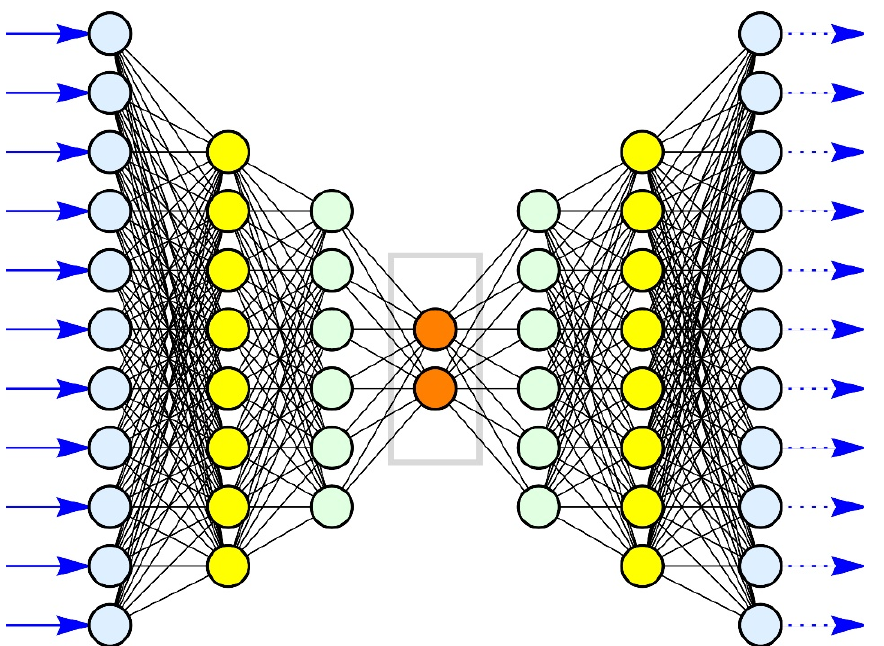
Figure 1. A symbolic rendition of an autoencoder used for dimension reduction. The 11 inputs (in the drawing) are represented by blue arrows from left to right. The inputs are conventionally labelled neurons (hence the name “neural network”). Each input neuron (light blue) has as many outputs as there are neurons in the next layer. Each ‘yellow’ neuron thus has 11 inputs/edges (represented as thin black lines). Each neuron in the yellow layer has as many outputs as there are neurons in the next layer: six outputs for each ‘yellow’ neuron and therefore eight inputs for each ‘green’ neuron of the next layer. It continues: each ‘green’ neuron has as many outputs as there are neurons in the next layer (consisting of two ‘orange’ neurons) and each ‘orange’ neuron has six inputs. The light blue neurons on the left are called the input layer while the light blue neurons on the right are called the output layer. The yellow layers, the green layers, and the orange layer are called the hidden layers. An autoencoder always has the same number of output neurons as it has input neurons. The number of hidden layers is part of the design by the engineer constructing the autoencoder. The numerical values along the black edges between neurons are determined by an algorithm. The autoencoder attempts to produce an output equal to the input (hence the name ‘autoencoder’) without being an identity mapping. An important feature for modern autoencoders is the ability to cut (set to zero) certain interconnections or make them numerically very small (usually by using a sigmoid function). The central layer is called the code. If the inputs are the feature vectors, then the numerical values of the code are the components of the dimension-reduced feature vector. If this is a successful autoencoder, it detects nonlinear combinations between the components of the (input) feature vector that can be represented by two